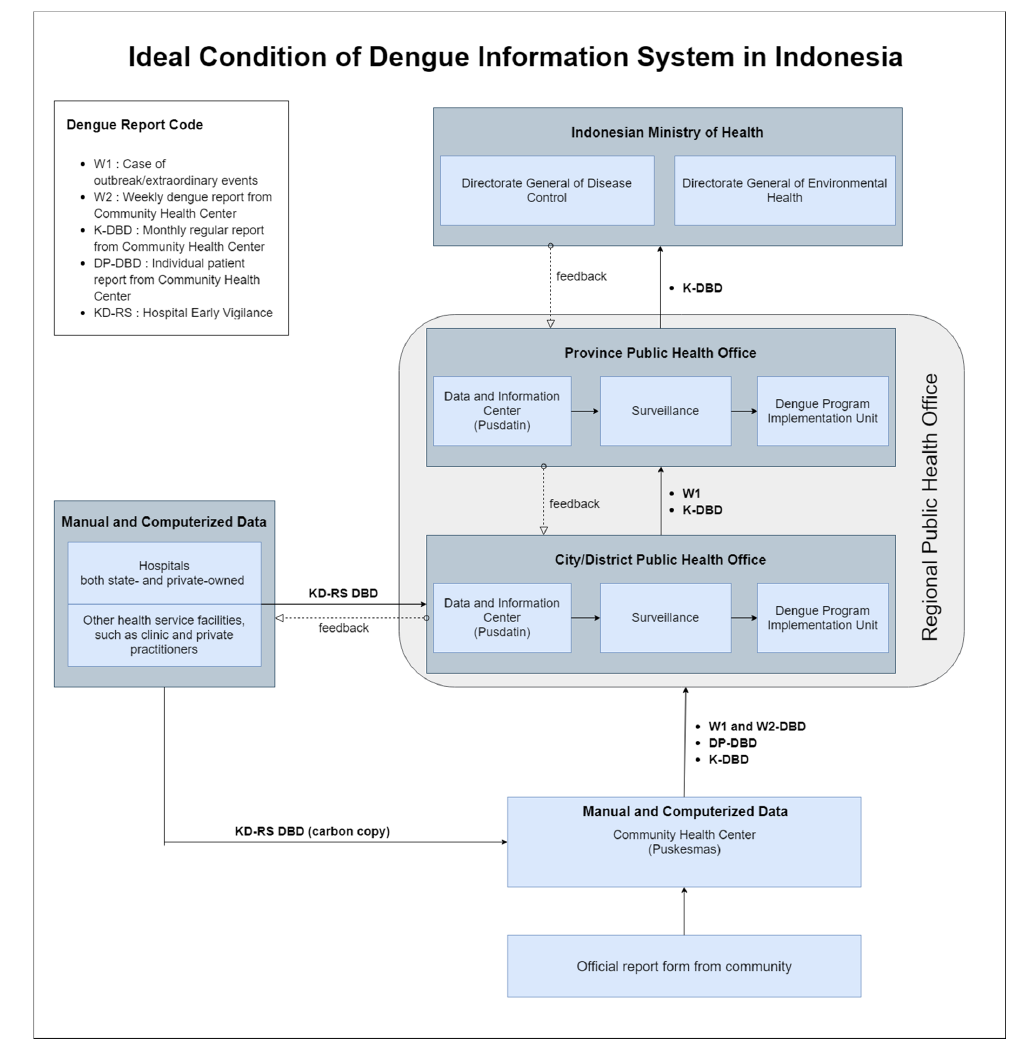
Figure 2 . Ideal condition of the dengue health information system, as described by the Indonesian Ministry of Health [31] .